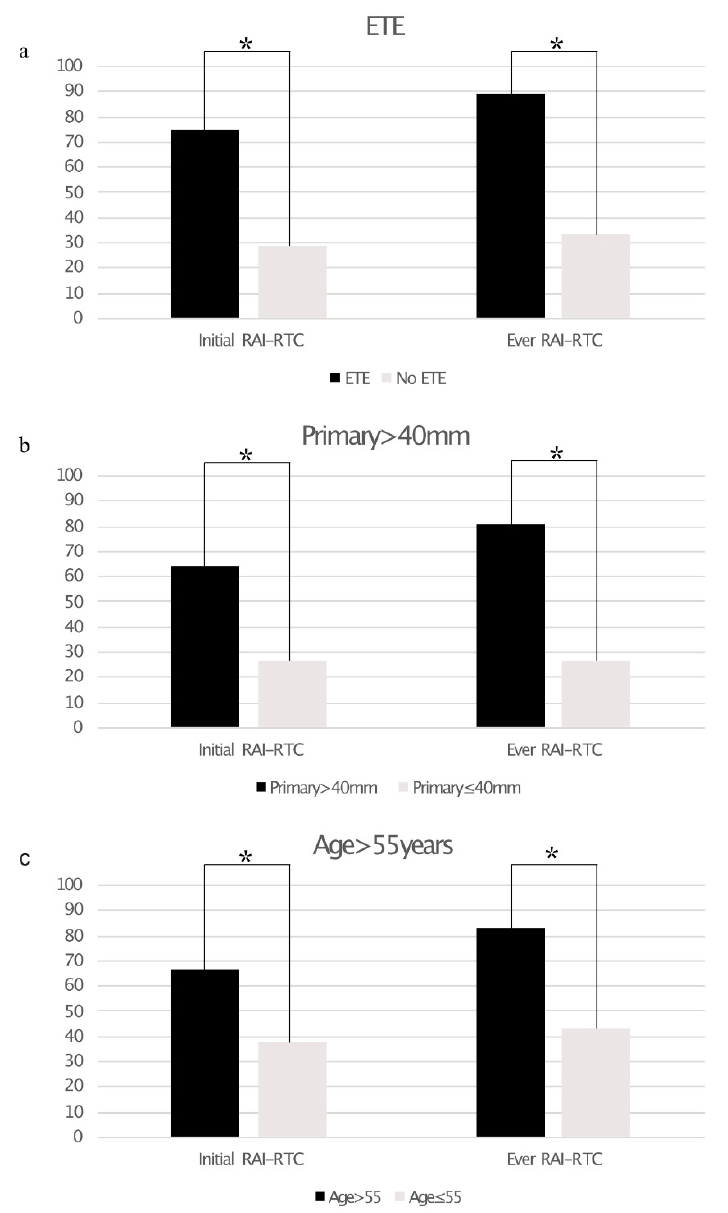
Figure 1. Bar graphs showing the prevalence of radioiodine refractory thyroid cancer (RAI-R TC) based on extrathyroidal extension (( a ), ETE), size of primary tumor >40 mm ( b ), and age >55 years ( c ). Statistically significant differences are marked with an asterisk *.